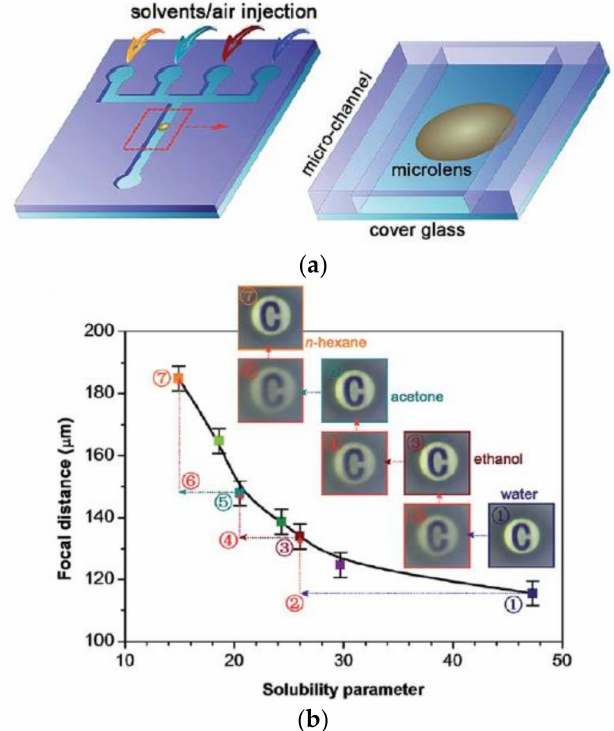
Figure 10. ( a ) Schematic diagram of microfluidic channel integrated with hyperboloid microlens; and ( b ) the relationship between the focal length of the microlens and the different solutions in the channel